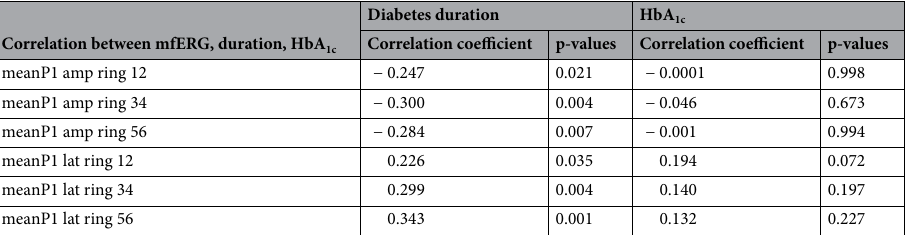
meanP1 lat ring 56 0.343 0.001 Table 3. Correlation between mfERG measures with HbA 1c and diabetes duration. Lat Latencies expressed as milliseconds; amp amplitude assessed as response density, nV/deg 2 .